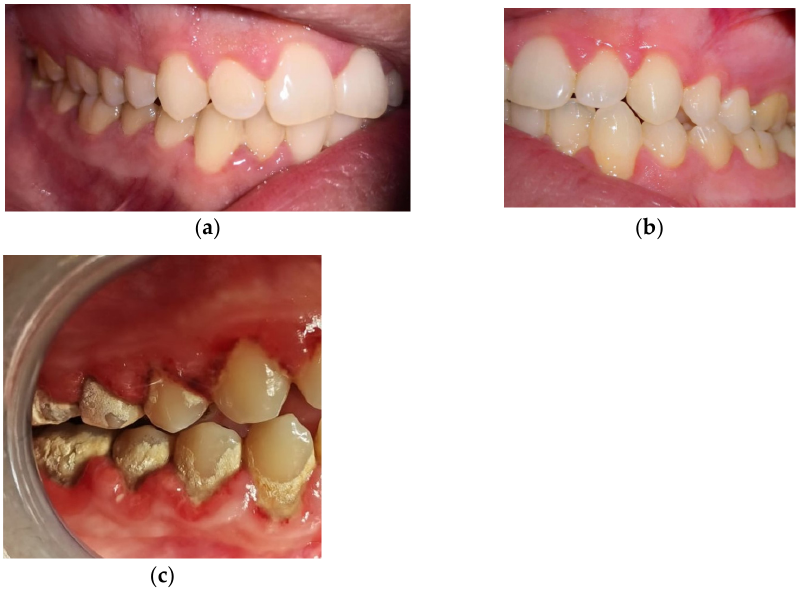
Figure 1. Clinical images of gingivitis: ( a ) mild inflammation-GI = 1; ( b ) moderate inflammation-GI = 2; and ( c ) severe inflammation-GI = 3.